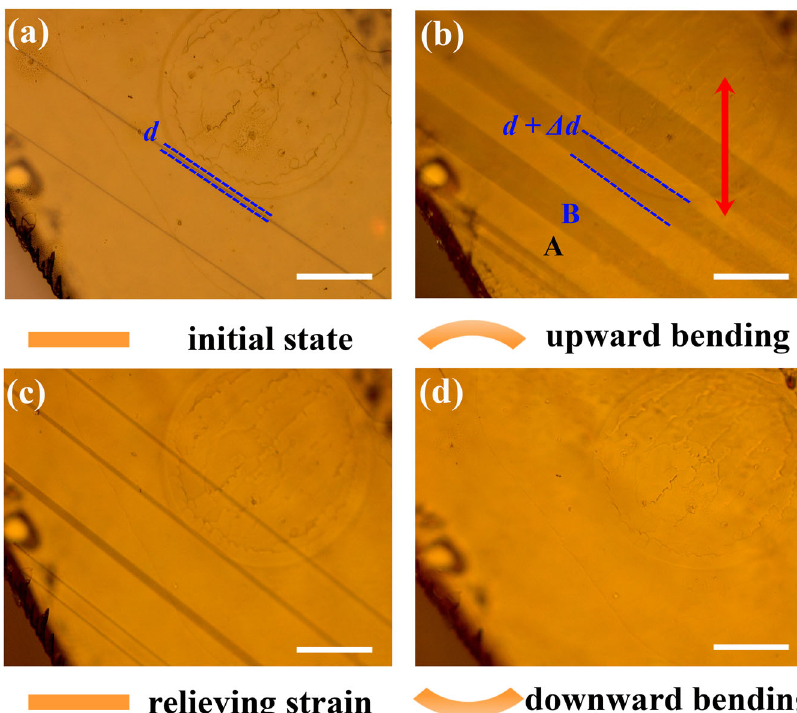
Fig. 4 Evolution of the ferroelastic domain structure under stress-and-relax cycles. a Polarization light image in original state of TSFC. b – d change in domain structure A and B under upward bending, unbend, downward bending sequence, showing hysteretic change in width of domains. The red two-way arrow represents the stress direction. d is the width of domain between the two blue dotted lines. Scale bar: 50 μ